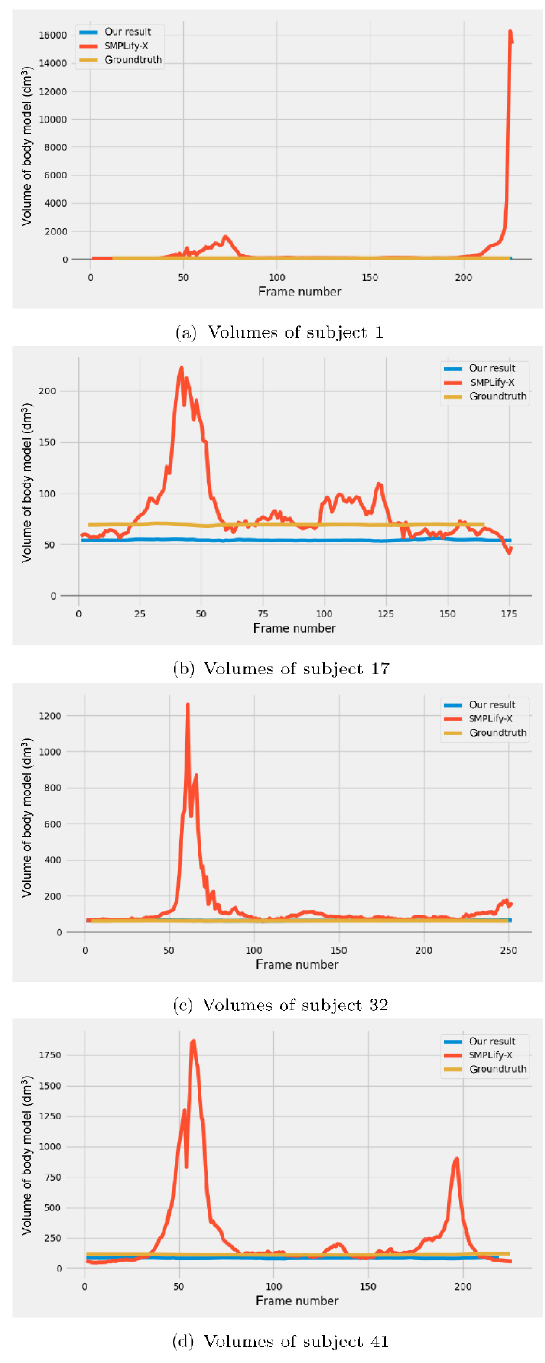
Fig. 9 Chronological sequences of body volume in body model estimation of Complex Motion. SMPLify-X results (red) have drastic deviations while our work’s results (blue) are close to the ground truth